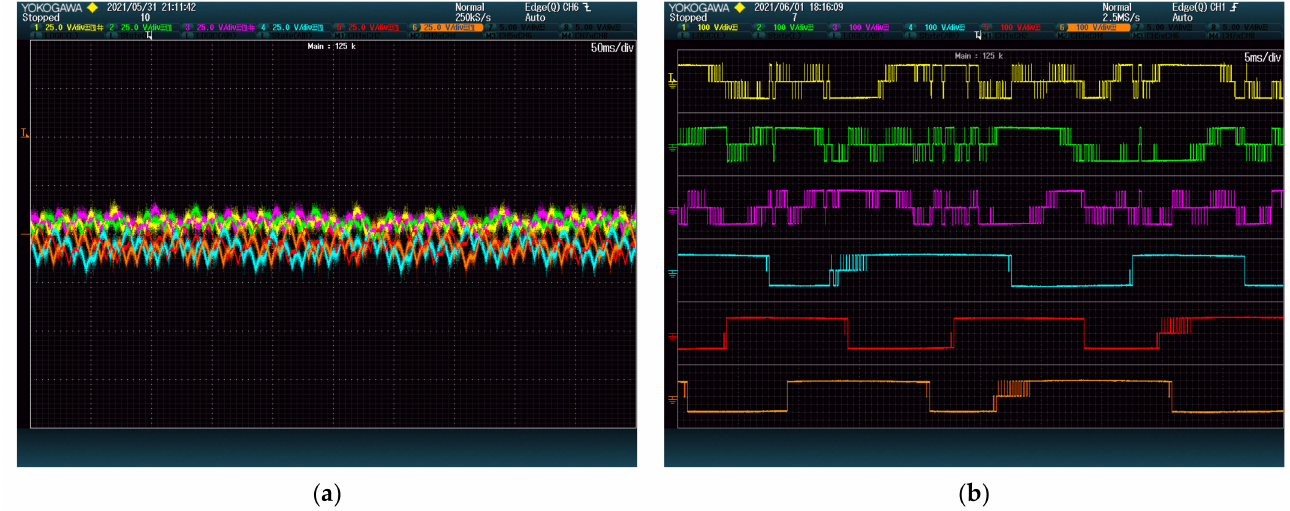
Figure 7. Fourth test results, with switching penalization on half of the modules ( G Sk 2 = 0.1): ( a ) DC-link